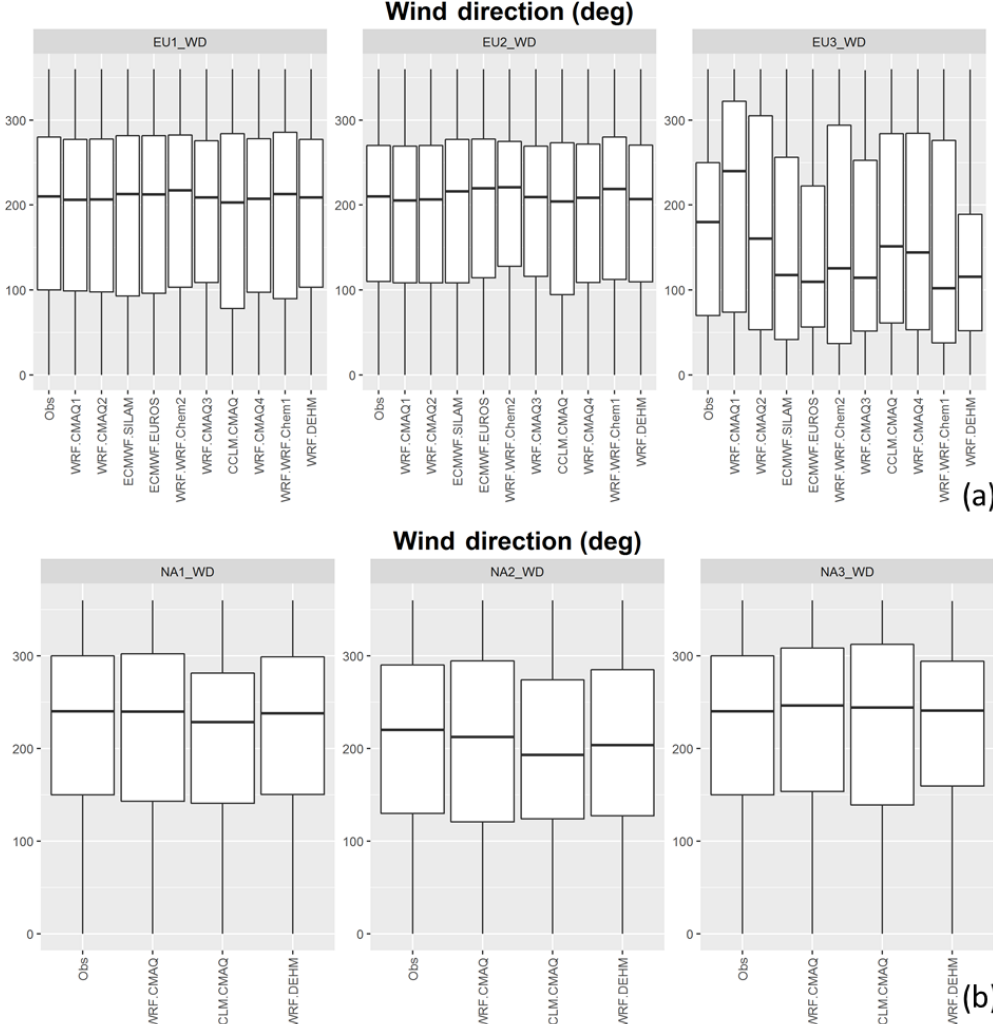
Figure 8. Spatial and temporal variability of the wind direction for (a) EU and (b) NA for the full year 2010. The boxes extend between the 25th and 75th percentiles of the total distribution. The whiskers extend from the minimum to the maximum